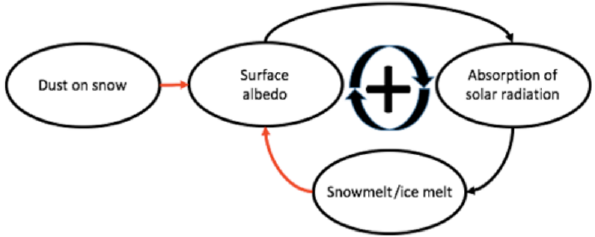
Figure 11. The feedback loop of the “dust–albedo effect” for Ice- landic dust events (perturbation), a new hypothesis that Icelandic dust deposited on snow can be a cause for Arctic amplification via such a positive feedback. Measurements show that black Icelandic dust particles are highly light absorbing, similar to soot particles (Peltoniemi et al.,